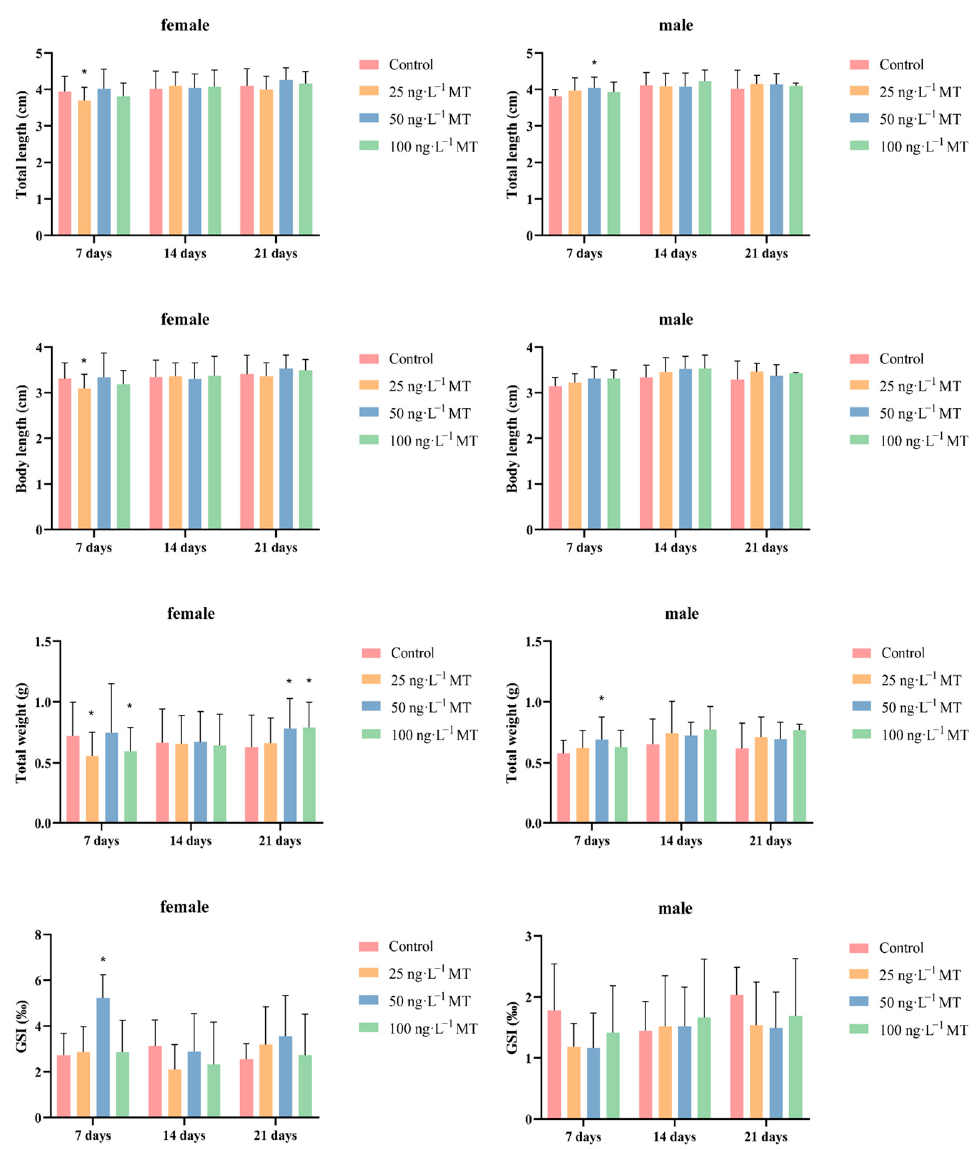
Figure 1. Morphological indexes and gonadosomatic index (GSI) of Gobiocypris rarus following MT exposure. Data are expressed as mean ± SD. Results were considered statistically significant for p < 0.05 (*).